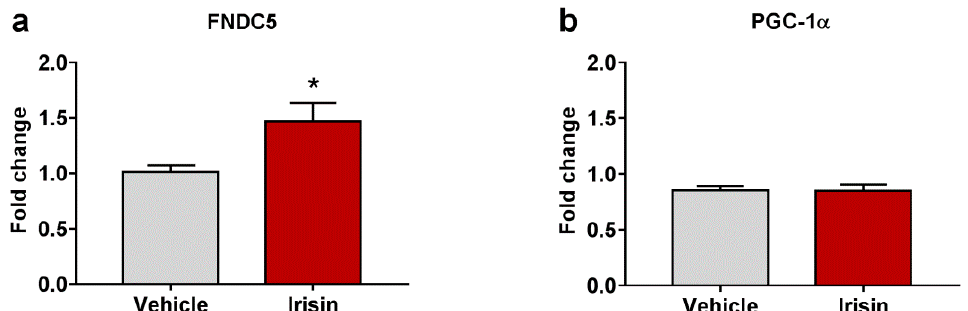
Figure 4. The effect of irisin treatment on FNDC5 brain expression. Gene expression of Fndc5 ( a ) and Pgc- 1α ( b ) was assessed by qRT-PCR. Histograms represent mean expression ± SEM. Unpaired two-tailed Student’s t-test was used for statistical analysis. * p < 0.05.